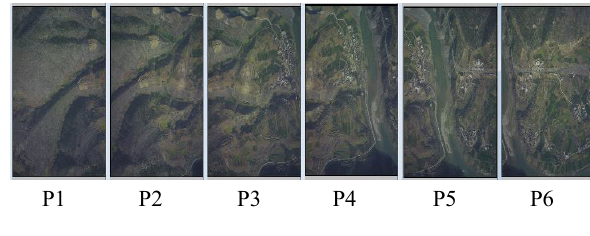
Figure 3. images overview.